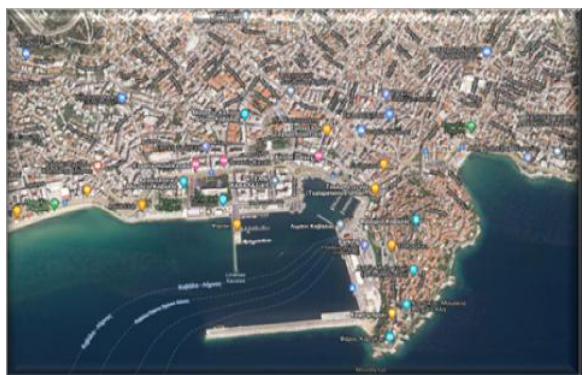
Figure 2 . Aerial Map of the Coastal front in Kavala